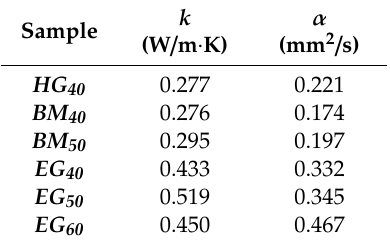
Table 5. Thermal conductivities ( k ) and thermal di ff usivities ( α ) of the studied composites.